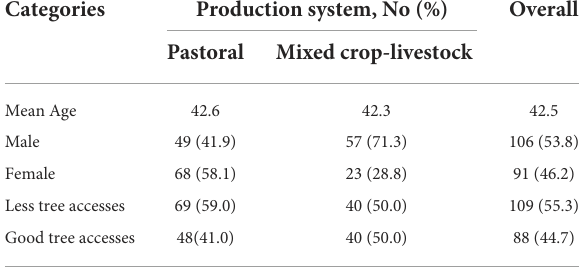
TABLE 3 Sociodemographic characteristics of study participants in the pastoral and mixed crop-livestock production system.